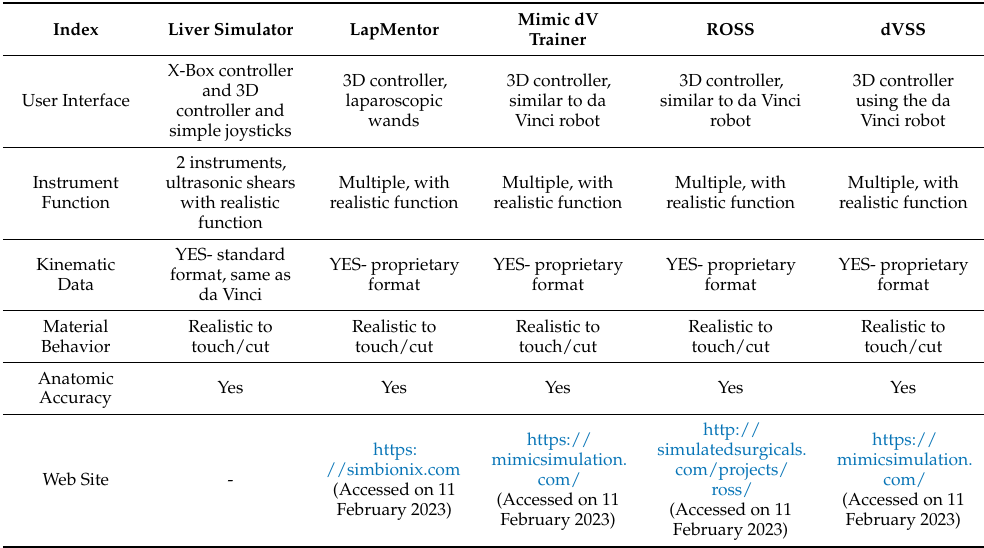
Table 6. VERIFY (Virtual Reality Fidelity) indices classification of Type 3 virtual reality robot-assisted surgery